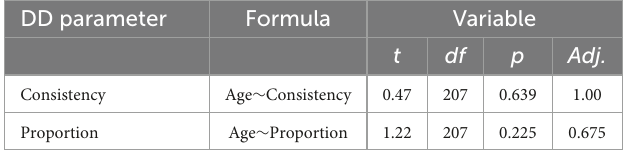
TABLE 1 Additional analysis of delay discounting parameters and age, using linear mixed-effect models for delayed discounting parameters in the 2020 cohort ( n =